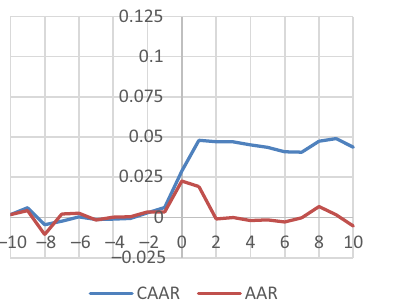
Figure 6. Market reaction of internal resource